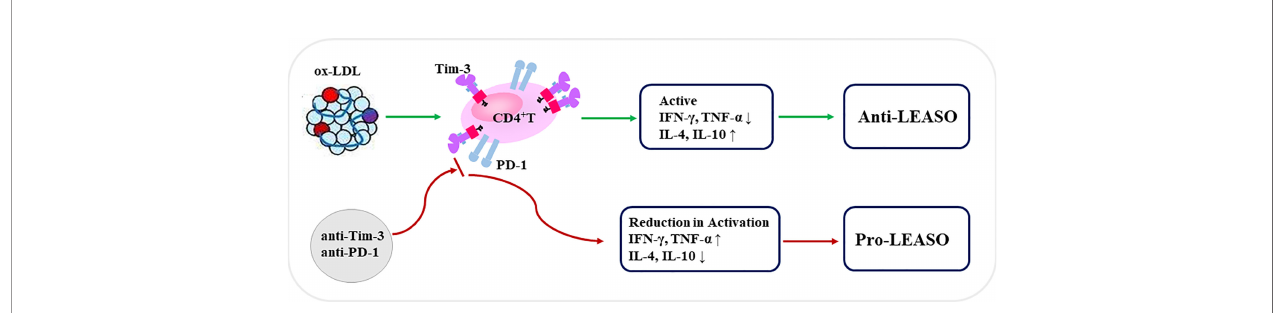
FIGURE 5 | Schematic diagram of Tim-3 and PD-1 signals in regulating CD4 + T cell function during LEASO. Ox-LDL increased the co-expression of Tim-3 and PD-1 on CD4 + T cells during LEASO. Tim-3/PD-1 pathways, in turn, may operate within the functional immune-modulatory network to prevent further in fl ammation in LEASO as Tim-3 + PD-1 + CD4 + T cells displayed a more active status and produced more anti-atherogenic cytokines. Meanwhile, the blockade of Tim-3 and PD-1 signaling pathways aggravated the pro-in fl ammatory Th1 responses predominating in LEASO, which might be conducive to the development